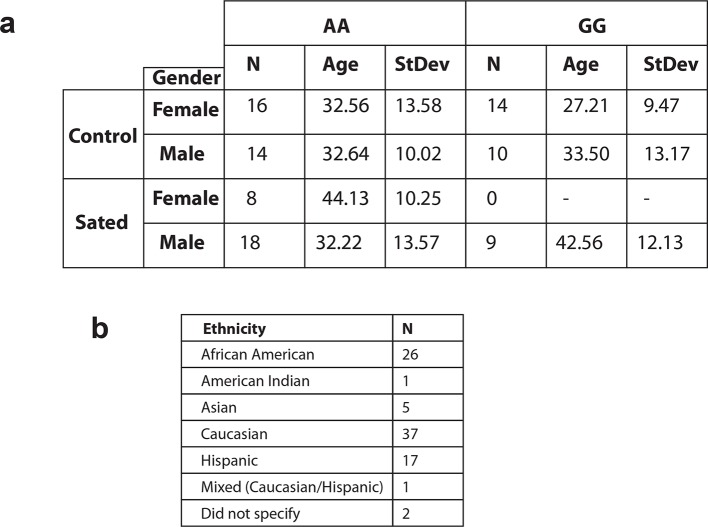
Demographic information of human participants involved in fMRI studies.(a) Table showing the number of participants by gender, age, and smoking status carrying the A or the G variant in the Eif2s1 gene. (b) Table showing the number of participants by their self-reported ethnicities The participants have no history of any other drug dependance.